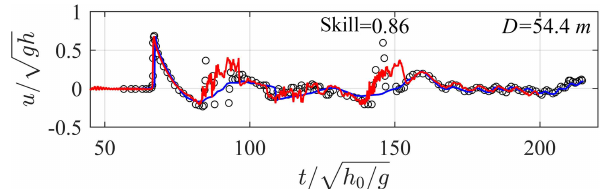
Figure 9. Time series of dimensionless streamwise velocity √ gh ) at the cross-shore distance D = 54 . 4m from the wave- ( u/ maker for Scenario 2. Red lines – present simulations; blue lines – simulations from Roeber (2010); open circles – measurements from Roeber (2010); skill values are for the present